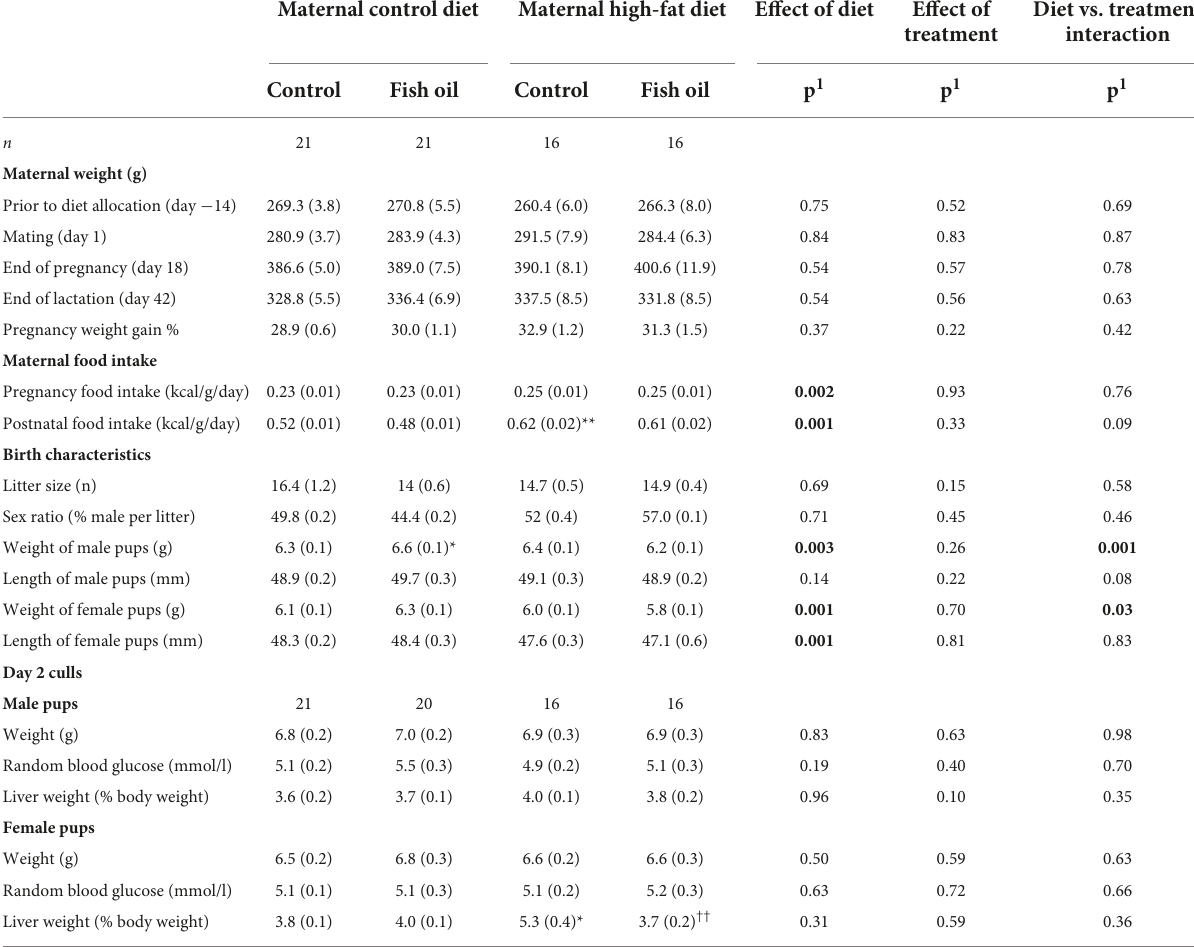
TABLE 3 Maternal weight and metabolic parameters at key milestones of the study and litter characteristics at birth, according to the maternal diet (control or high-fat diet) and the gel treatment during pregnancy [fish oil or control (no oil gel)]. Maternal control diet Maternal high-fat